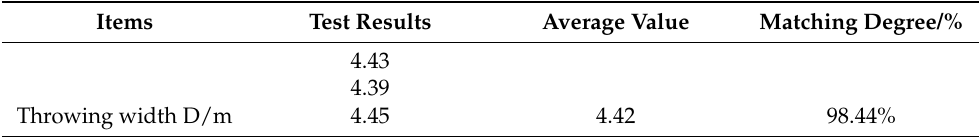
Table 5. The effect of throwing width after SCTD